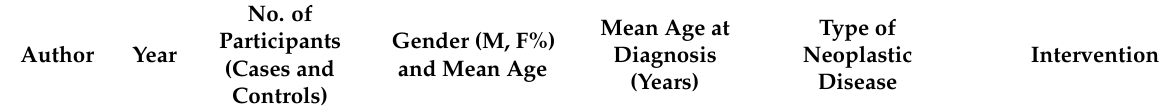
Table 1. Main data of the included